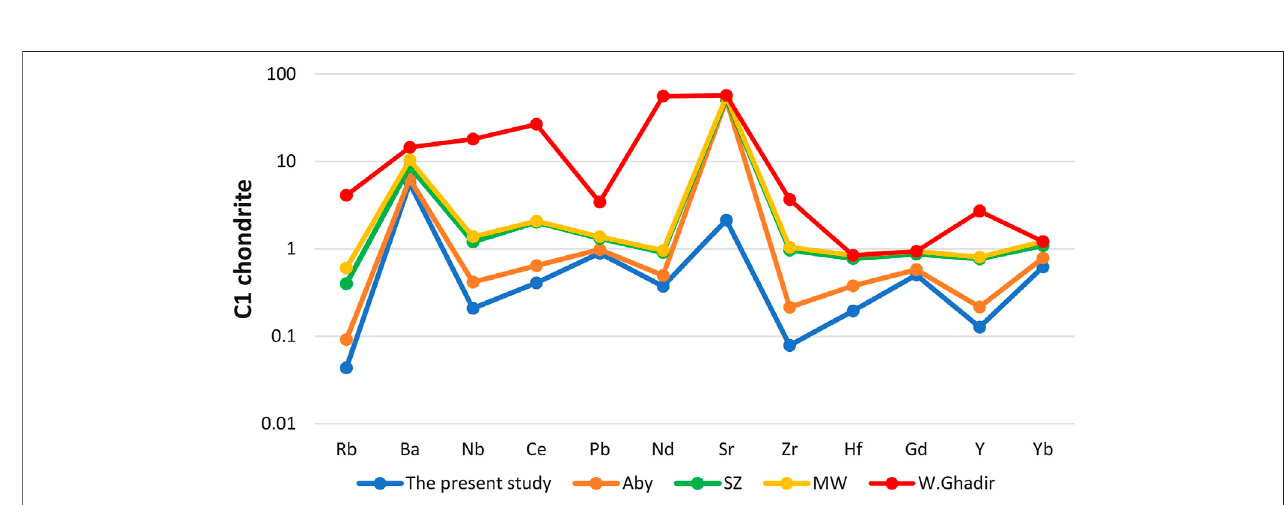
FIGURE 10 | C1-chondrite-normalized patterns (according to McDonough and Sun, 1995) of trace and REE in the studied serpentinites showing a comparison between the present study, Wadi Ghadir after Surour (2017) and average of abyssal, SZ, and mantle wedge after Deschamps et al. (2013).